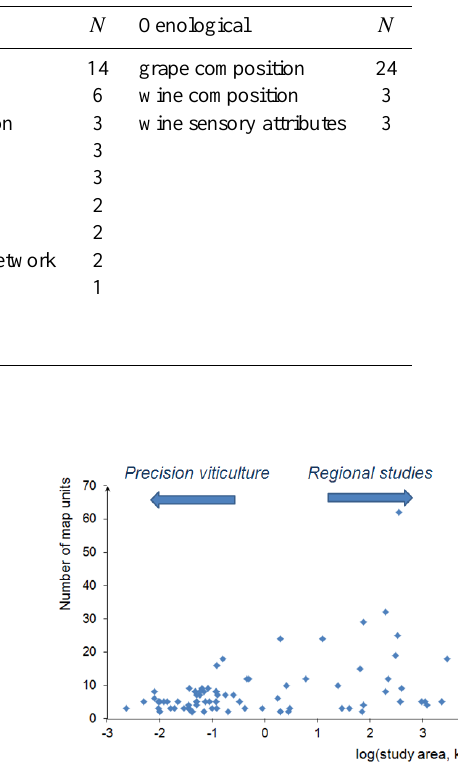
Figure 3. Plot of the number of map units vs. the log of the study area in studies published from 2002 to 2014 (see Fig.